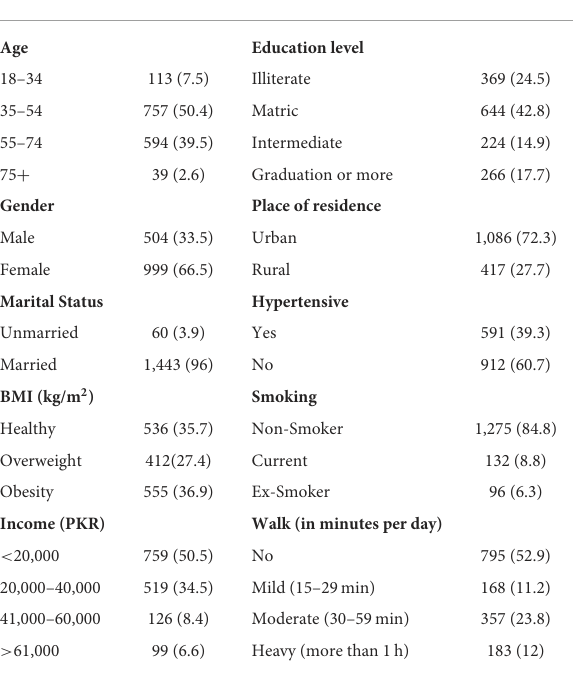
TABLE 1 Demographic and socioeconomic characteristics of the study